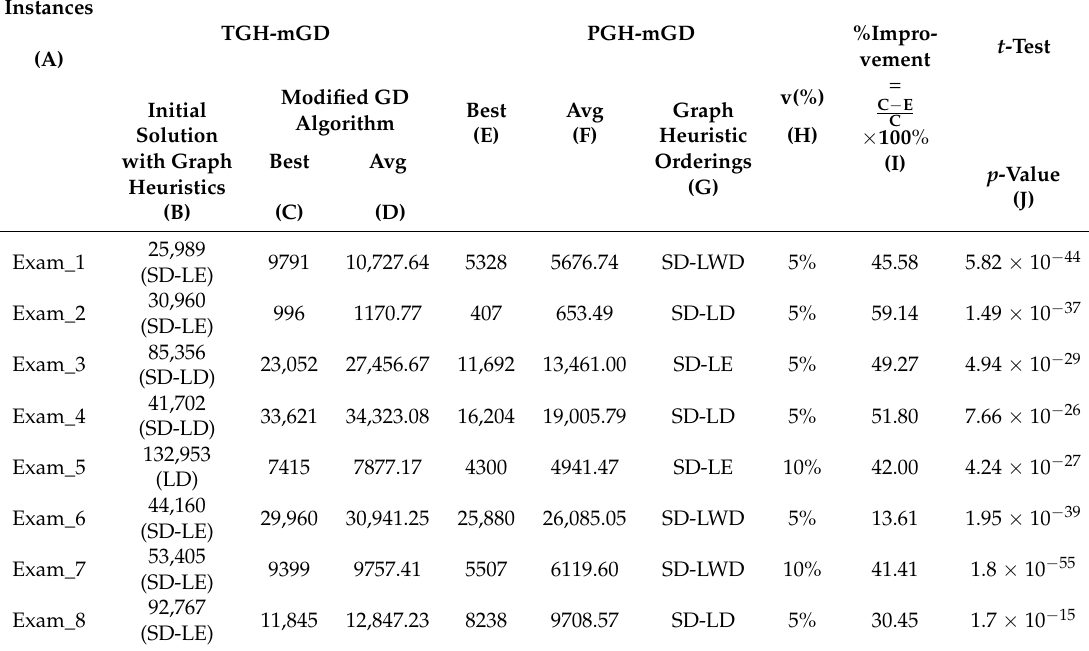
Table 7. Comparisons of results between TGH-mGD and PGH-mGD for the ITC2007 exam dataset.